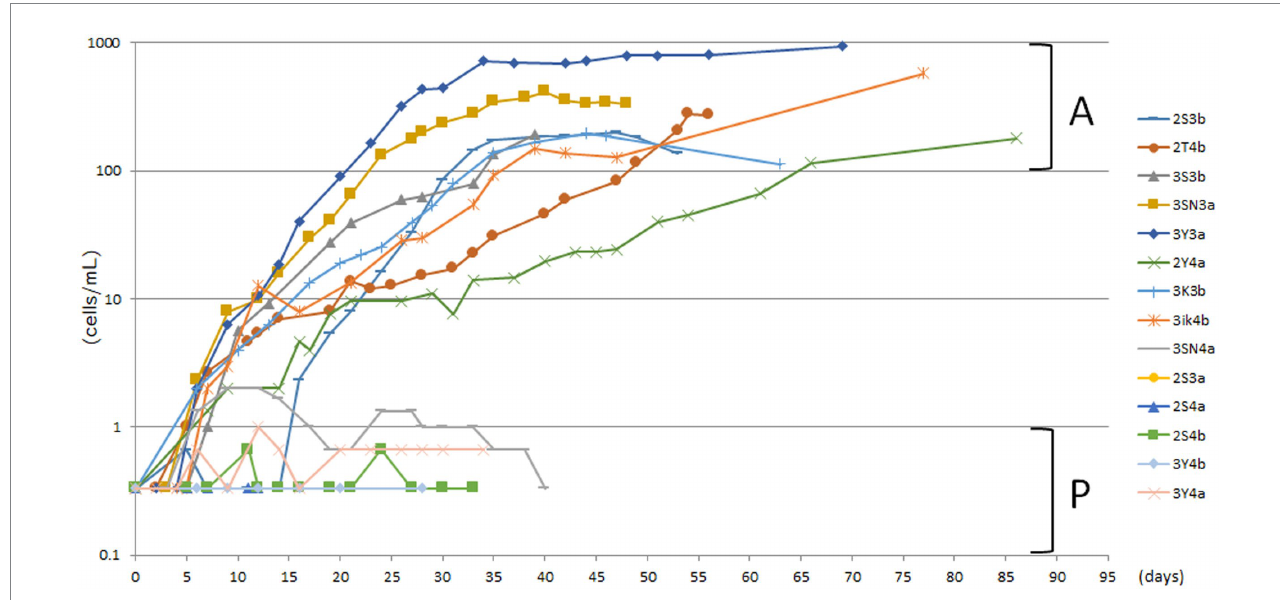
FIGURE 2 Actively and poorly proliferating strains in unfed cultures of P. bursaria . Strains with a stationary phase cell density of 100 cells/mL or more were defined as actively proliferating strains (A), and those with a stationary phase cell density of 1 cell/mL or less were defined as poorly proliferating strains (P). Among these strains, eight and six representative strains were selected as A and P, respectively. The names of each of the 14 strains are shown on the right-hand side. The top eight and the bottom six listed vertically in the figure correspond to strains A and P, respectively. The abscissa represents the number of days from the start of culture and the ordinate represents the cell